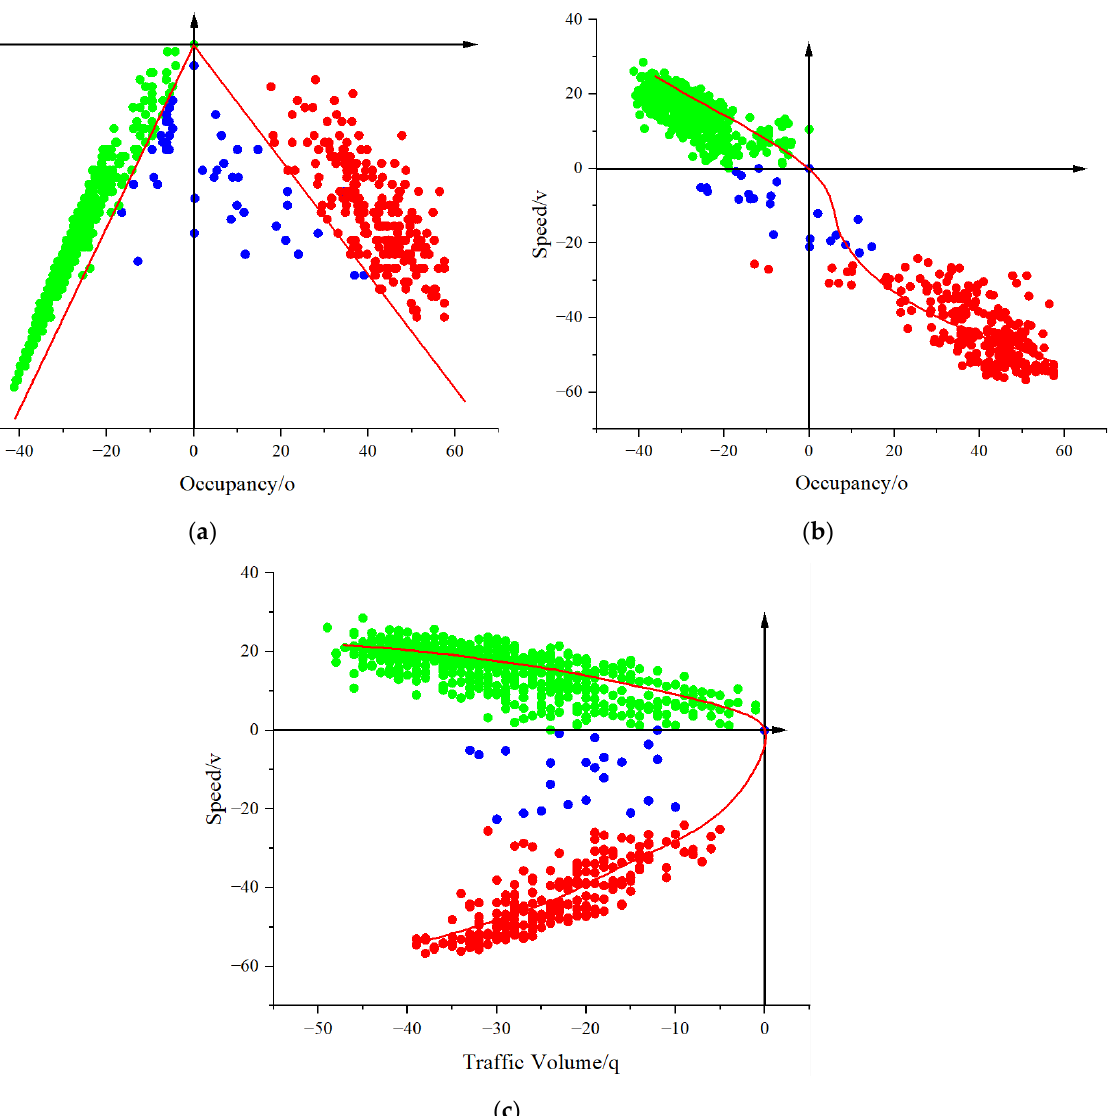
Figure 8. Distribution of traffic flow parameters in cusp catastrophe model. ( a ) Traffic volume— occupancy distribution; ( b ) Speed—occupancy distribution; ( c ) Speed—traffic volume distribution.